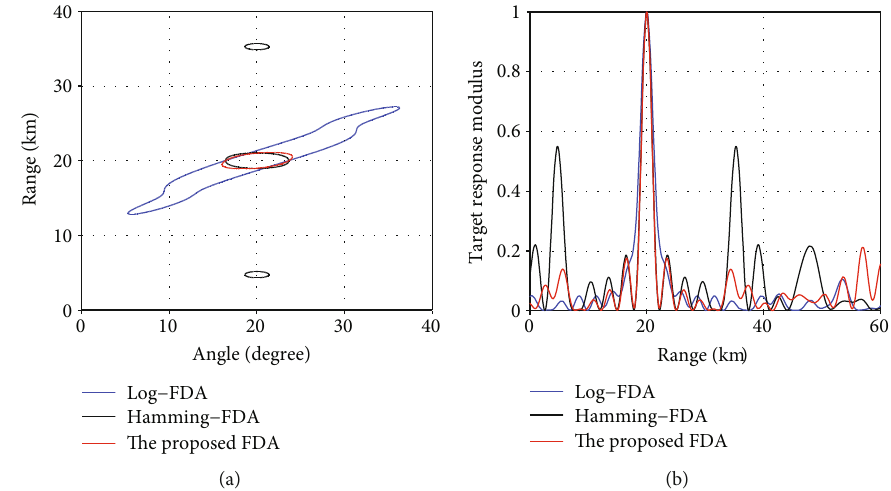
Figure 5: Comparative results of (a) half-power beam width of transmit beampatterns; (b) transmit beampatterns in the pro fi le of range.